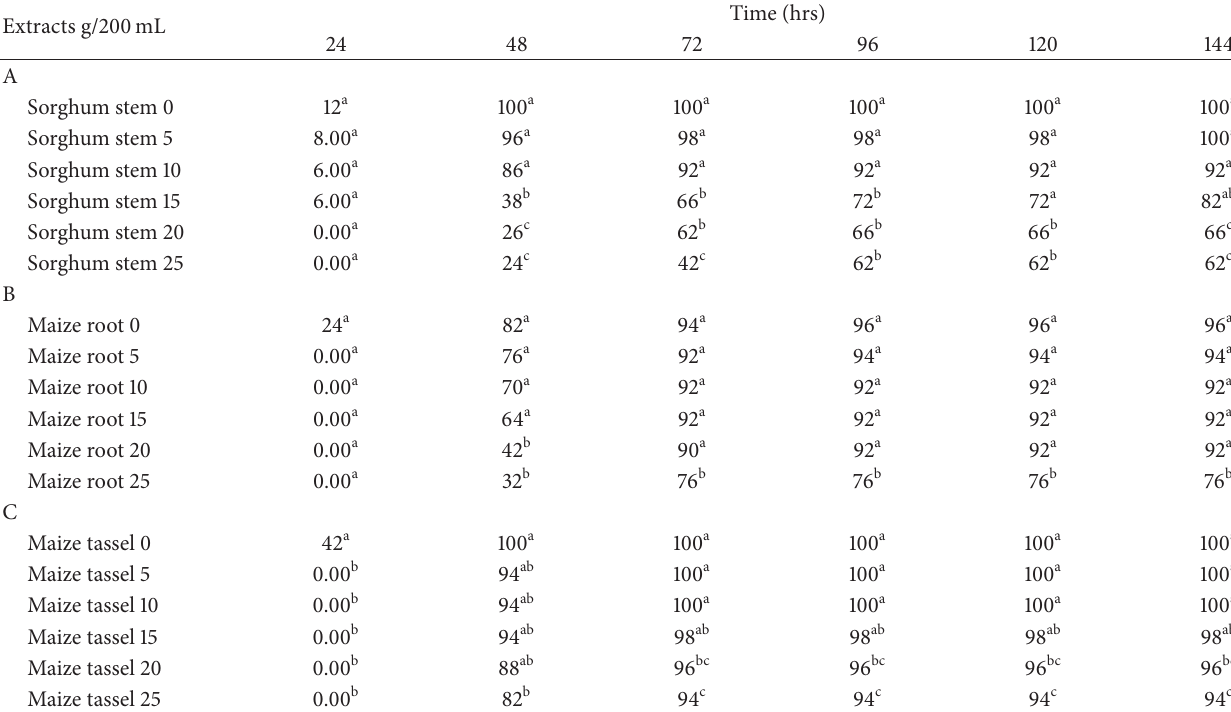
Table 1: Effects of aqueous extracts of sorghum stem and maize (roots and tassel) on the germination % of seeds of okra. Extracts g/200